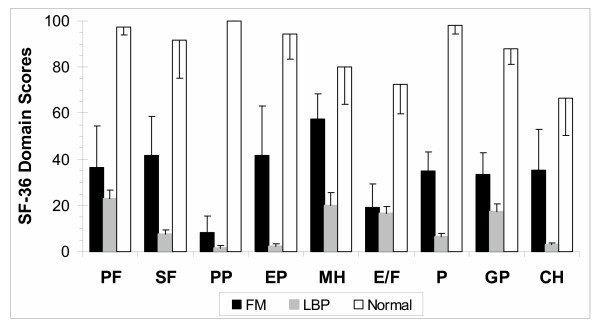
SF-36 domain results. Scores were ranked Normal (white bars with down-going 95%CI) > FM (black bars with up-going 95%CI) > LBP (grey bars with up-going 95%CI). The Normal group had significantly higher scores than FM for EP (p ≤ 0.05), SF (p ≤ 0.01), PF, PP, E/F, P and GP, but not MH or CH. All Normal means were highly significantly greater (p ≤ 0.001) than all LBP scores. FM scores were higher than LBP for EP, GP, and CH (p ≤ 0.05), SF (p ≤ 0.01), and MH and P (p ≤ 0.001). FM and LBP were not different for PF, PP or E/F.